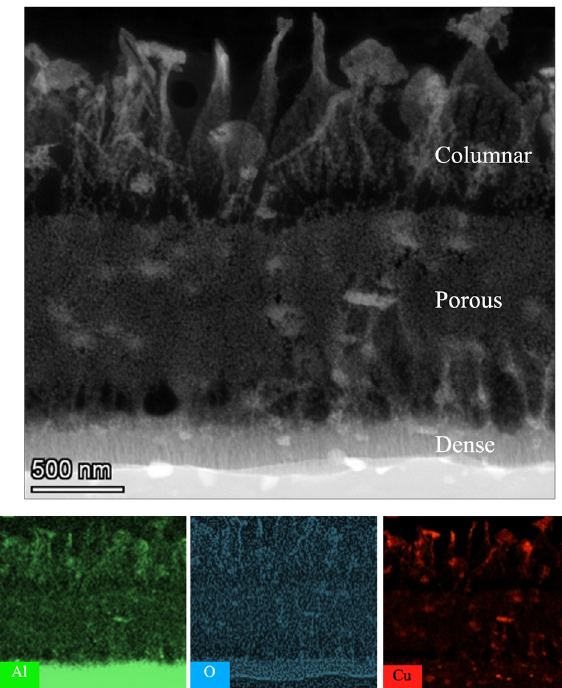
Fig. 5 Post-mortem analysis of the conversion layer formed on a sandwiched specimen in 0.01 M NaCl + 0.01 M Li 2 CO 3 . HAADF- STEM/EDS analysis of the preformed conversion layer, showing a multi-layered arrangement. Furthermore, Al, O and Cu are identi fi ed as main elements incorporated into the layer. Cu-rich regions are the corroded nanometric intermetallic particles. Note that lithium cannot be detected via EDS technique.